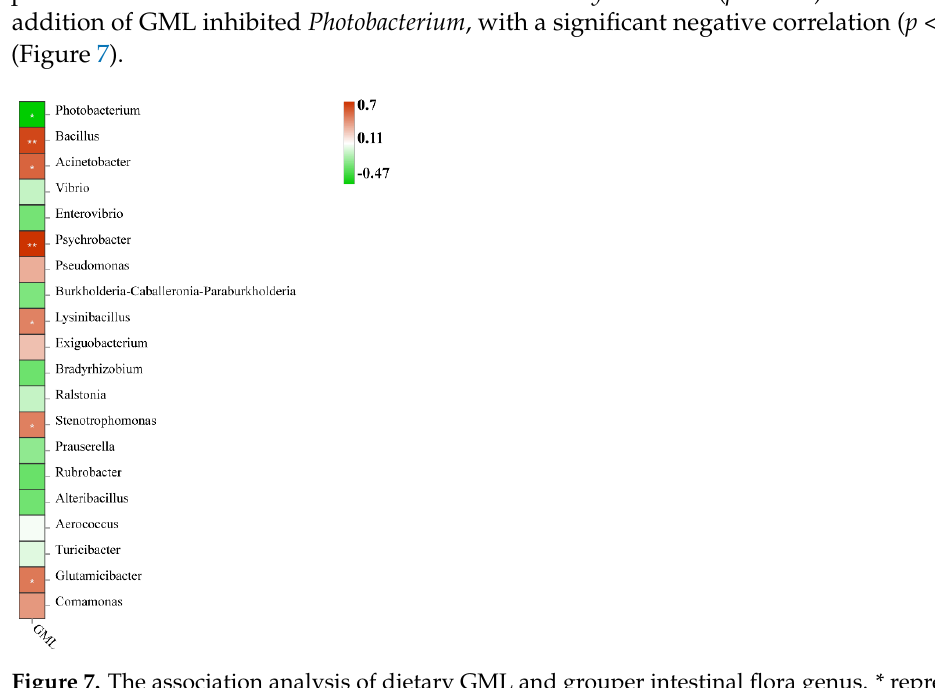
Figure 7. The association analysis of dietary GML and grouper intestinal flora genus. * represents significant difference, p < 0.05; ** represents highly significant difference, p < 0.01.